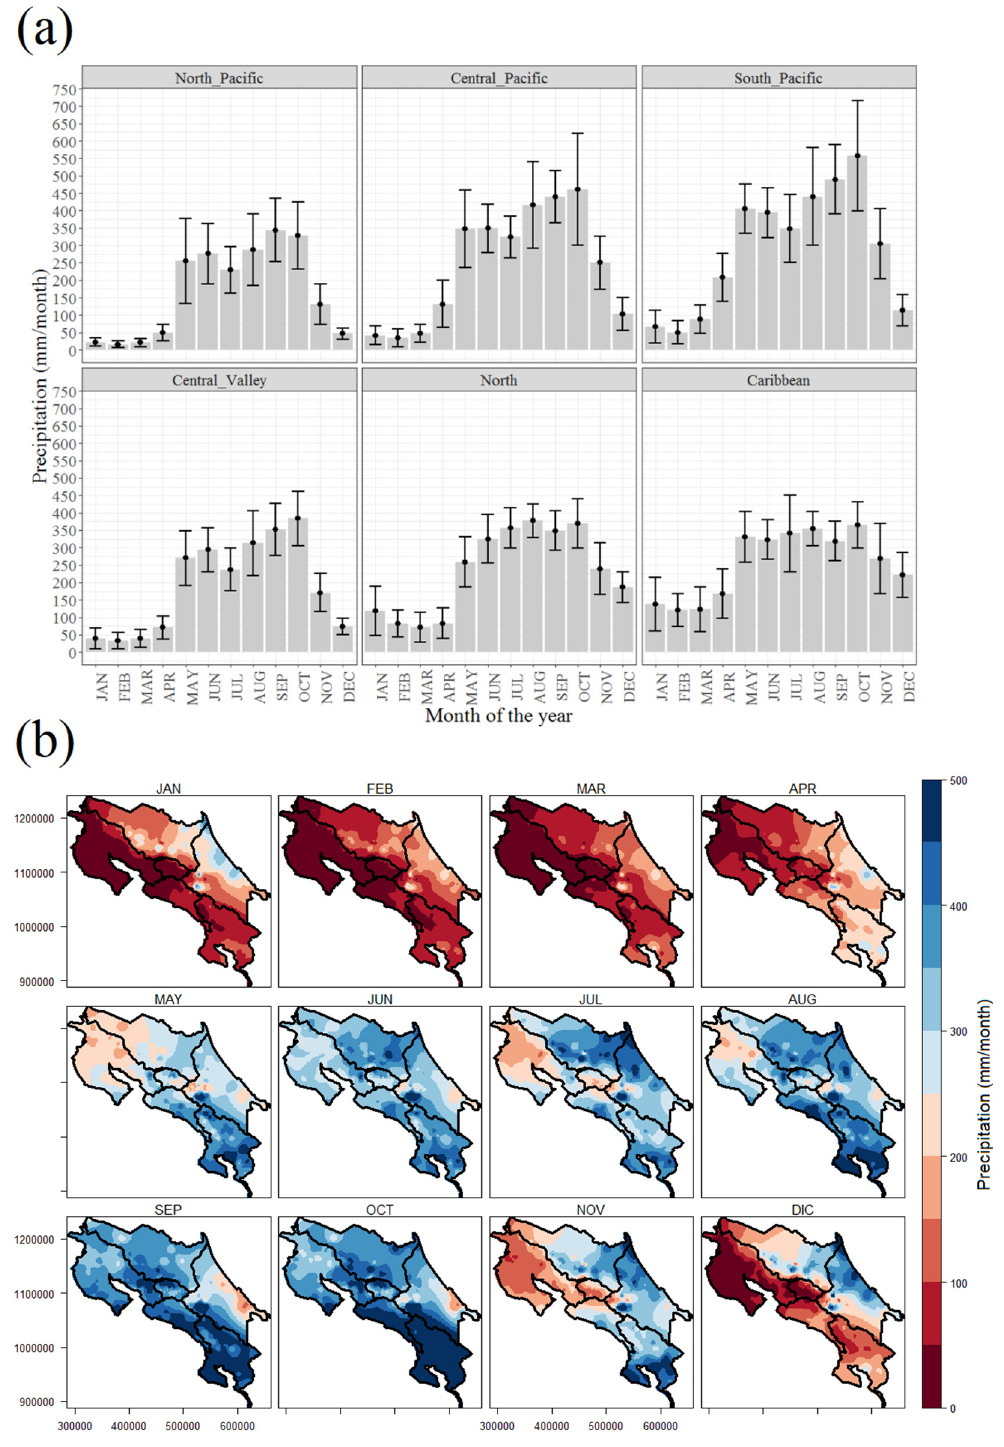
Figure 2. ( a ) Spatially-averaged mean monthly precipitation for each climatic region of Costa Rica based on 1951–1995 grid climatology. Error bars represent the standard deviation. ( b ) Same as ( a ) but spatially-distributed.